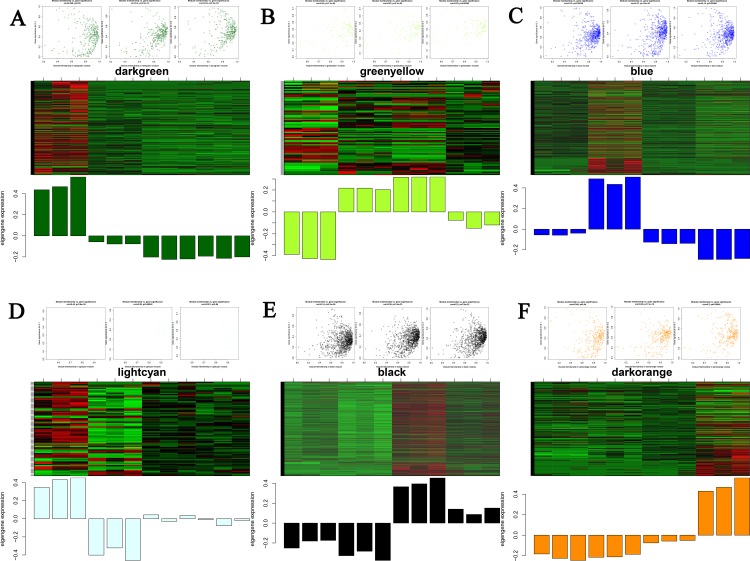
Visualization of GS vs. MM and expression level in stage-specific modules.The scatter plot shows the distribution of the GS and MM of genes in stage-specific modules related to one sample. The P-value represents the significance of a module related to one stage. The heatmap and bar plot correspond to the expression level (ME) of genes in a stage-specific module in the 12 samples (from left to right: I0-1, I0-2, I0-3, I2-1, I2-2, I2-3, I4-1, I4-2, I4-3, I6-1, I6-2, and I6-3).